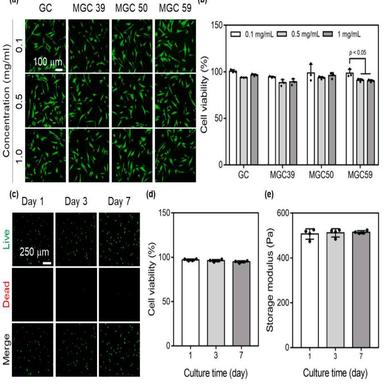
In vitro cytocompatibility. (a) Live/dead staining images (green: live cells, red: dead cells, and scale bar = 100 μm) and (b) MTT assay (n = 3) of hDFB cells cultured in the media treated with GC, MGC39, MGC50, and MGC59 depending on their various concentrations. (c) Live/dead images and (d) quantitative results of viability of hDFB cells, encapsulated within the photo-crosslinked MGC50 thermogels and cultured for 1, 3, and 7 days (scale bar = 250 mm). (e) The storage moduli of the photo-crosslinked MGC50